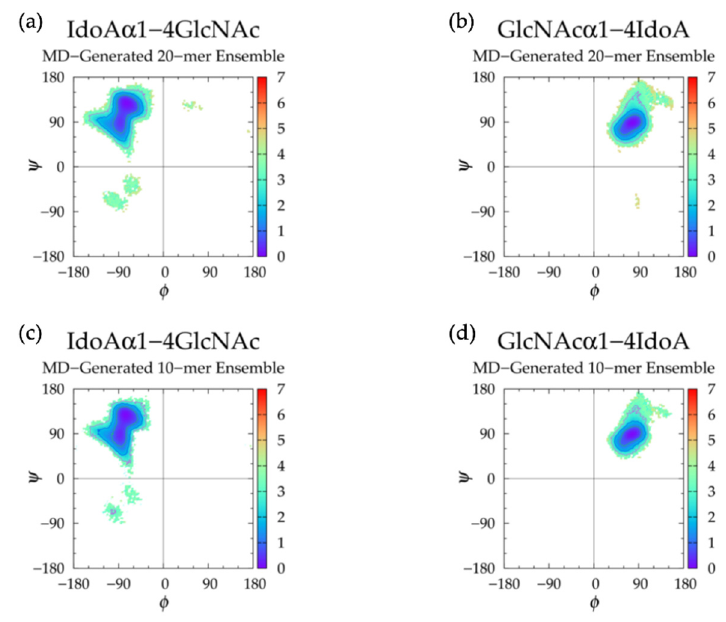
Figure 21. Δ G ( ϕ , ψ ) in the MD-generated nonsulfated heparan ensembles for aggregated IdoA α 1-4GlcNAc and GlcNAc α 1-4IdoA glycosidic linkage data in the ( a , b ) 20-mer and ( c , d ) 10-mer, respectively; contour lines every 1 kcal/mol. Table 8. Nonsulfated Heparan Glycosidic Linkage Dihedrals ( ϕ , ψ ) 1 and Free Energy ( Δ G ( ϕ , ψ ) kcal/mol) Minima.